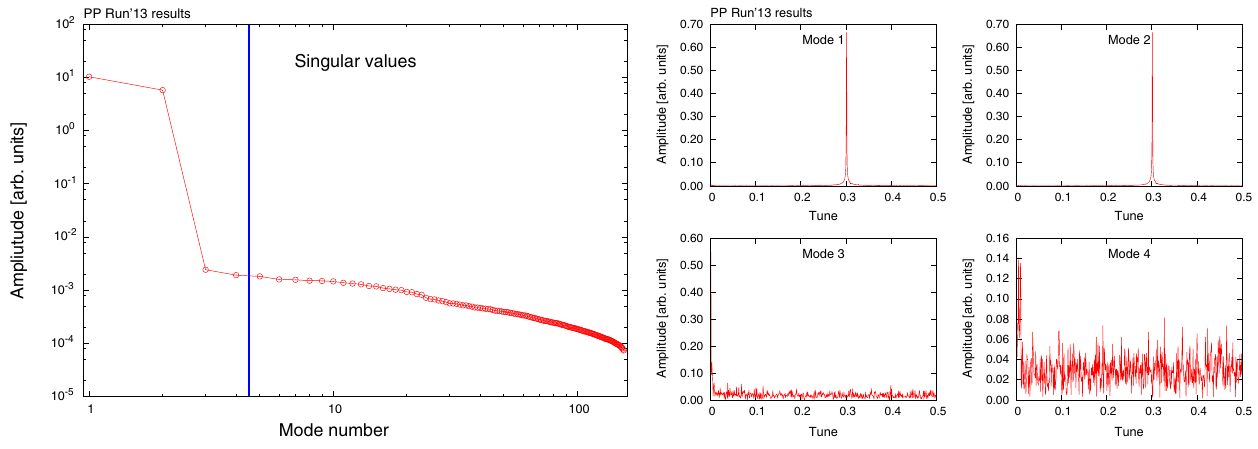
FIG. 3. Typical distribution of singular values for one set of experimental data of PP collision with an intensity of 1 . 2 × 10 11 . The cutoff mode number is chosen to be n c ¼ 4 . Right: Typical spectrum of temporal function for the corresponding modes 1 – 4. Modes 1 and 2 correspond to betatron motion, while modes 3 and 4 are related to the low-frequency synchrotron